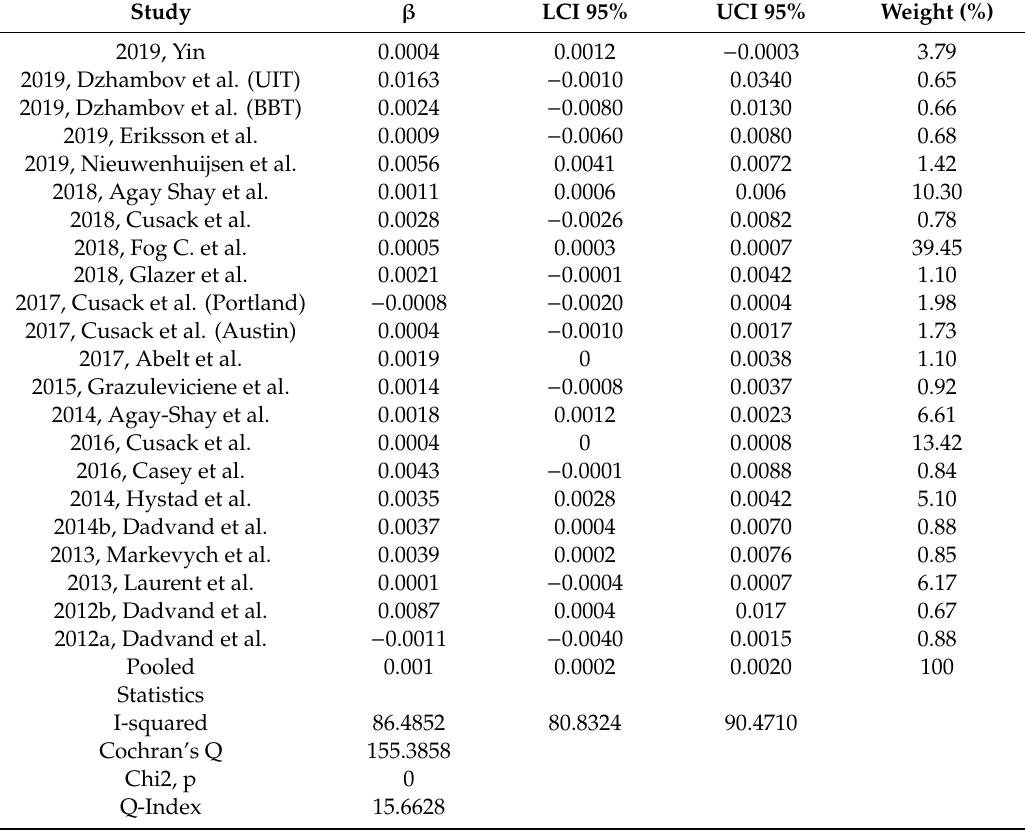
Table 1. Meta-analysis results for the e ff ect of Normalized Di ff erence Vegetation Index (NDVI) increase on birth weight (standardized regression coe ffi cients, quality e ff ects model);